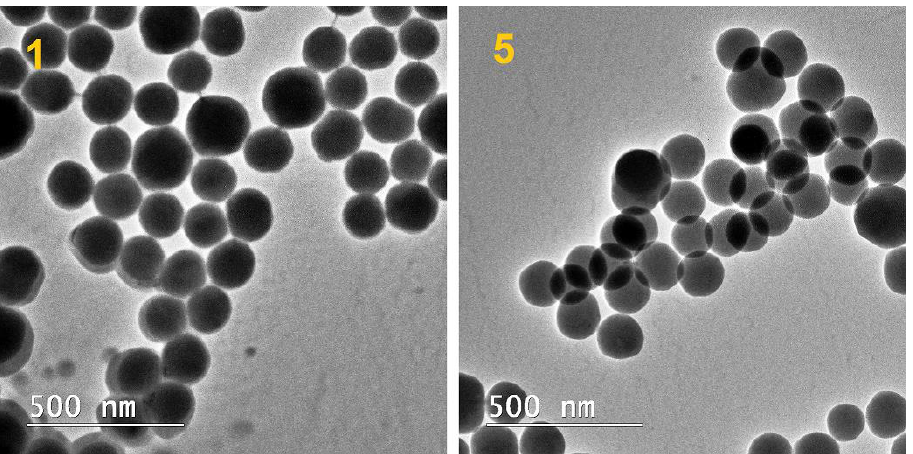
Figure 4. TEM images of dried pristine SiO 2 NPs ( sample 1 ) and dried SiO 2 NPs modified with long alkyl chain ( sample 5 ), dispersed in ethanol.